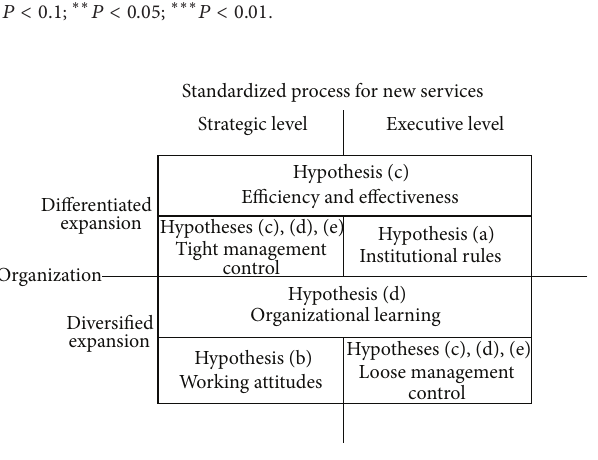
Figure 1: The summarized results from hypotheses.